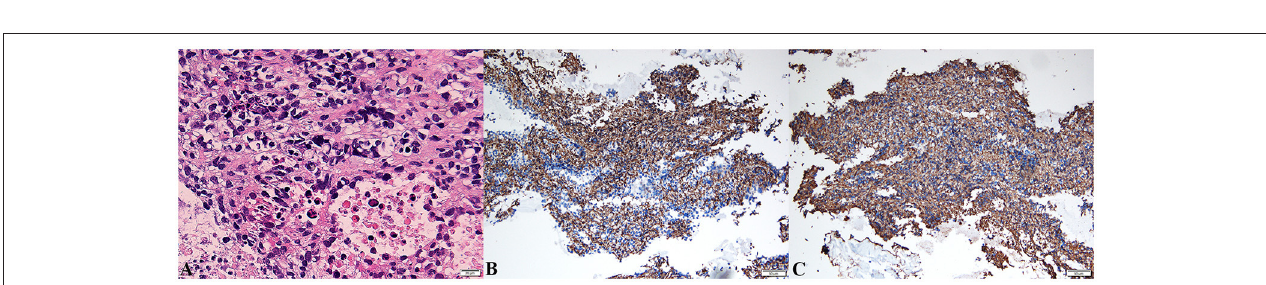
FIGURE 4 | Biopsy of pericardial mass showed pleomorphic spindle and ovoid tumor cells with atypia and mitotic [hematoxylin–eosin stain, original magnification × 400, (A) ]. The malignant cells were strongly positive for CD31 [blue, × 200, (B) ] and CD34 [blue, × 200, (C) ] in immunohistochemistry.